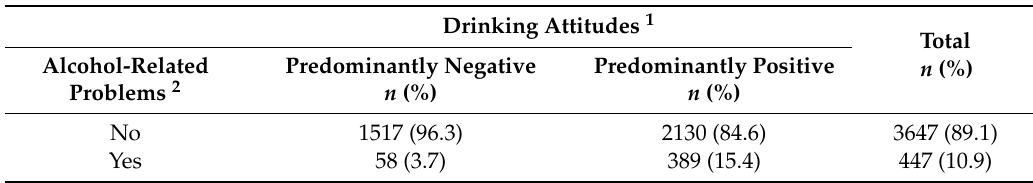
Table 3. Alcohol-related problems by drinking attitudes.